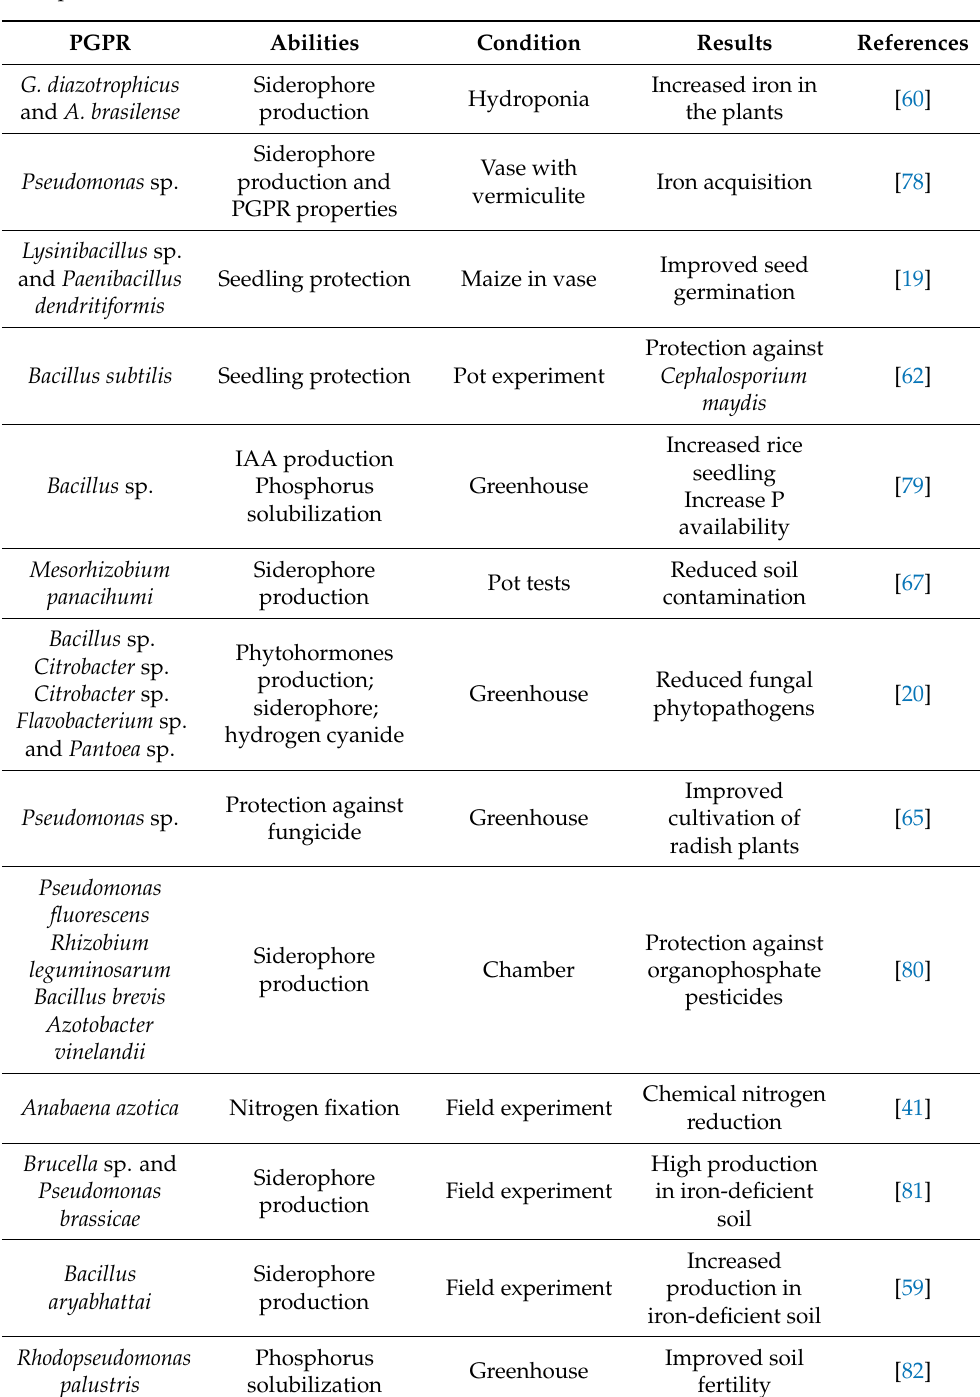
Table 1. Bacterial species, abilities, experimental conditions, and results achieved by the application in